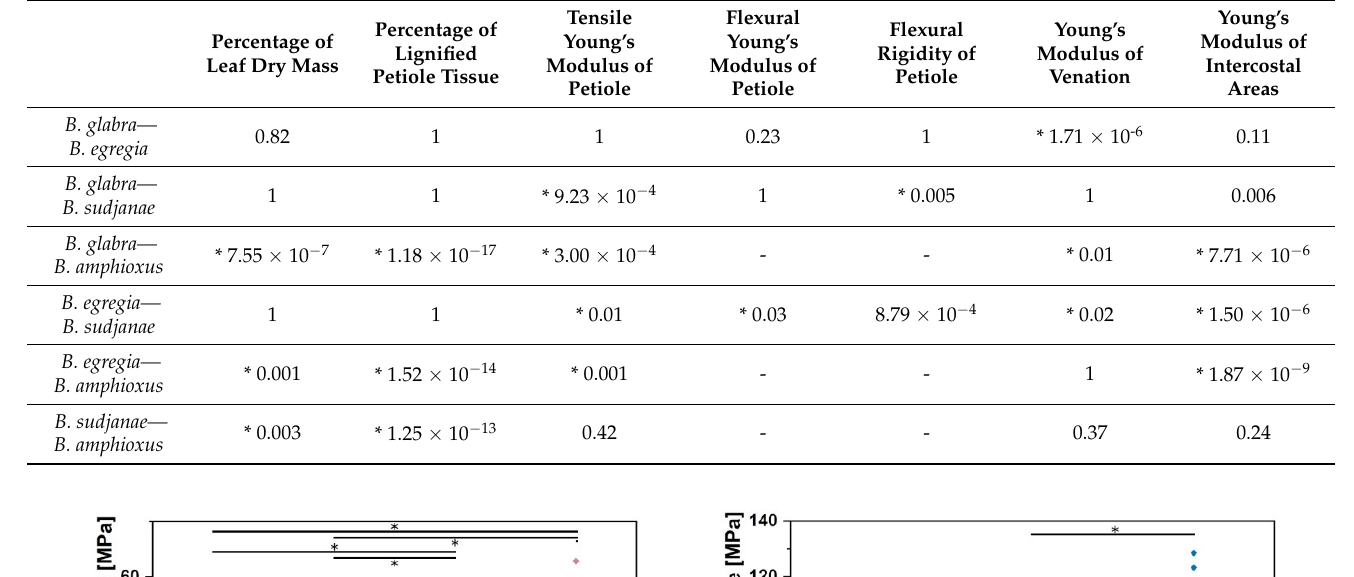
Table 2. p -values from Dunn’s tests after Kruskal–Wallis ANOVA. Associated plots with marked significant differences and sample sizes are shown in Figures 3 and 4 (significance level is 0.05, significant values marked with *).